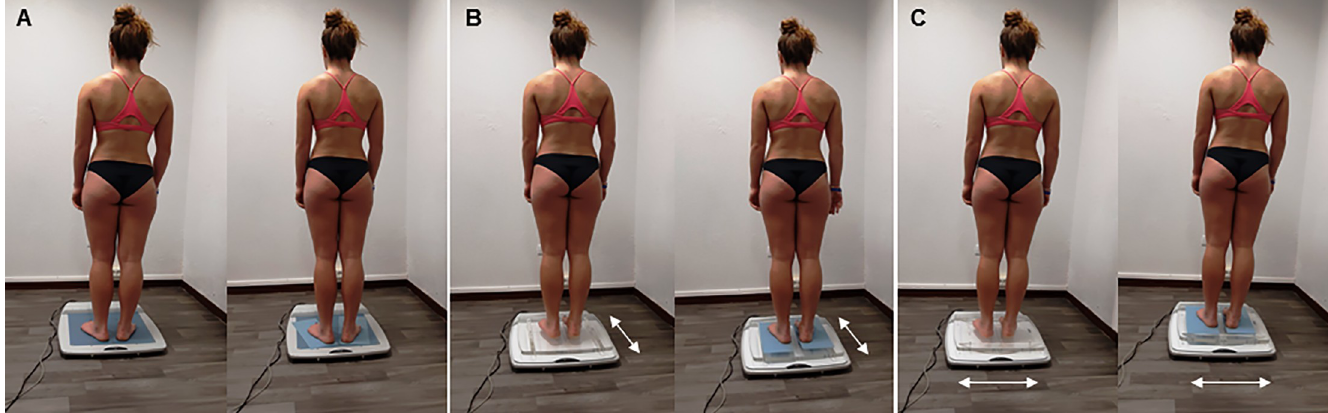
Fig 1. Experimental conditions and set-up: STA balance wF and noF (A); AP balance wF and noF (B); ML balance wF and noF (C). EO and EC conditions were recorded for each balance condition. The individual in this manuscript has given written informed consent to publish this figure.